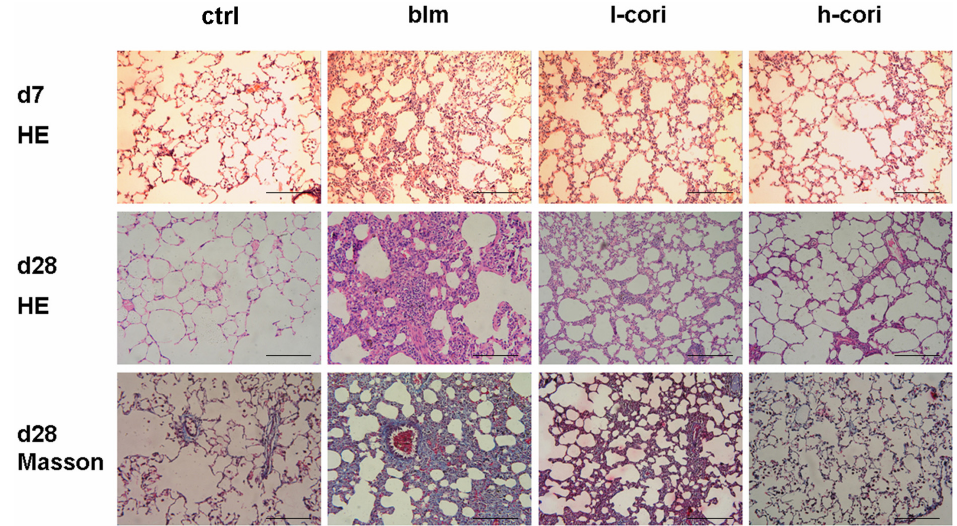
Figure 3. Representative lung pathology images on days 7 and 28 in each group. Dramatic alveolar and massive septal collagen deposition were manifested in the blm group, followed by l-cori group, while the lung architecture remained intact in the h-cori group. Collagen was stained blue with Masson’s trichrome. H&E and Masson’s trichrome, scale bars represent 200 µm.